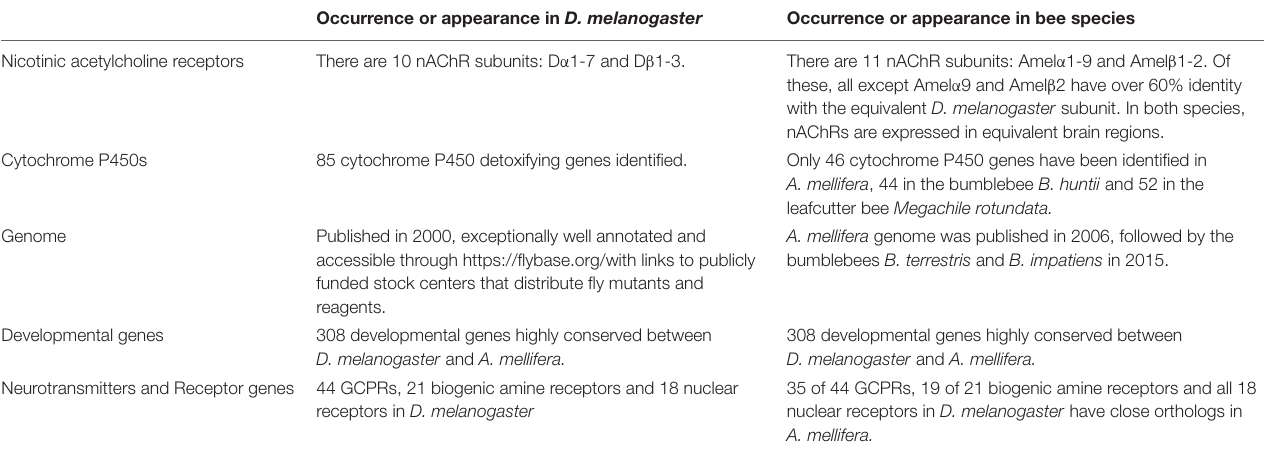
TABLE 1 | Comparison of genetic and molecular factors in D. melanogaster and bee species, to assess the usefulness of D. melanogaster as an insect model for pollinators. Occurrence or appearance in D. melanogaster Occurrence or appearance in bee species Nicotinic acetylcholine receptors There are 10 nAChR subunits: D α 1-7 and D β